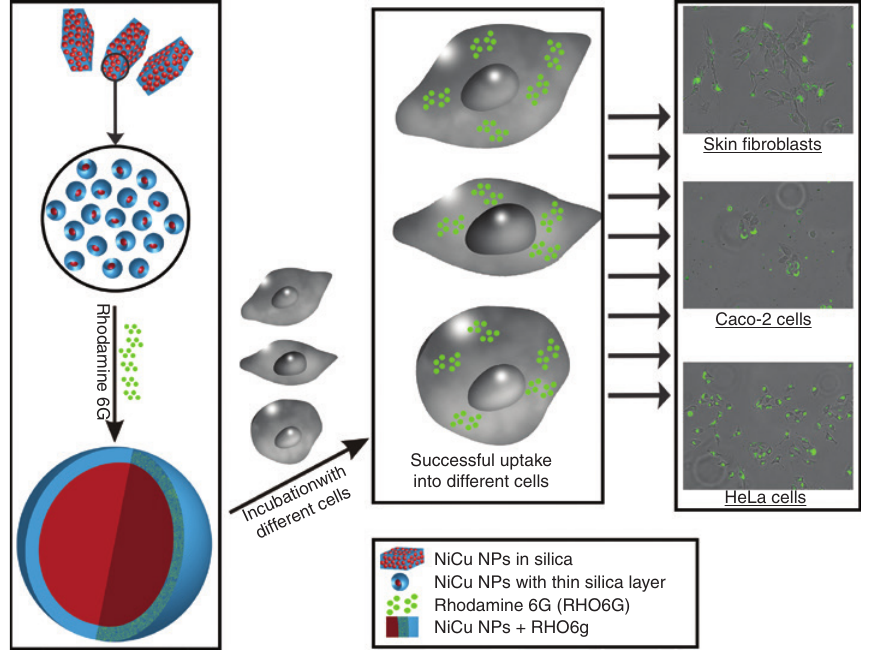
Figure 16: Potential use of NiCu MNPs as an efficient material for a bimodal cancer therapy (simultaneously enabling magnetic hyperther- mia and providing the possibility to target and position them as the desired target site). Reproduced with permission from Springer: Journal of Sol-Gel Science and Technology